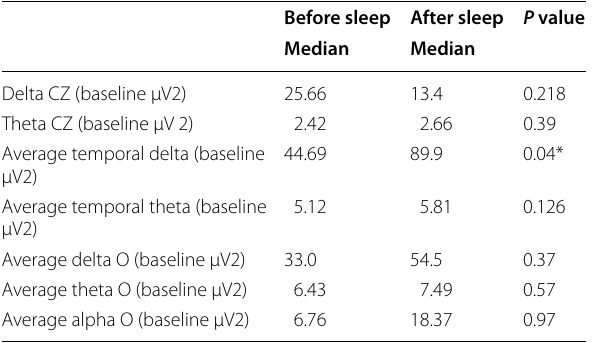
Table 2 Comparing QEEG before and after sleep in the